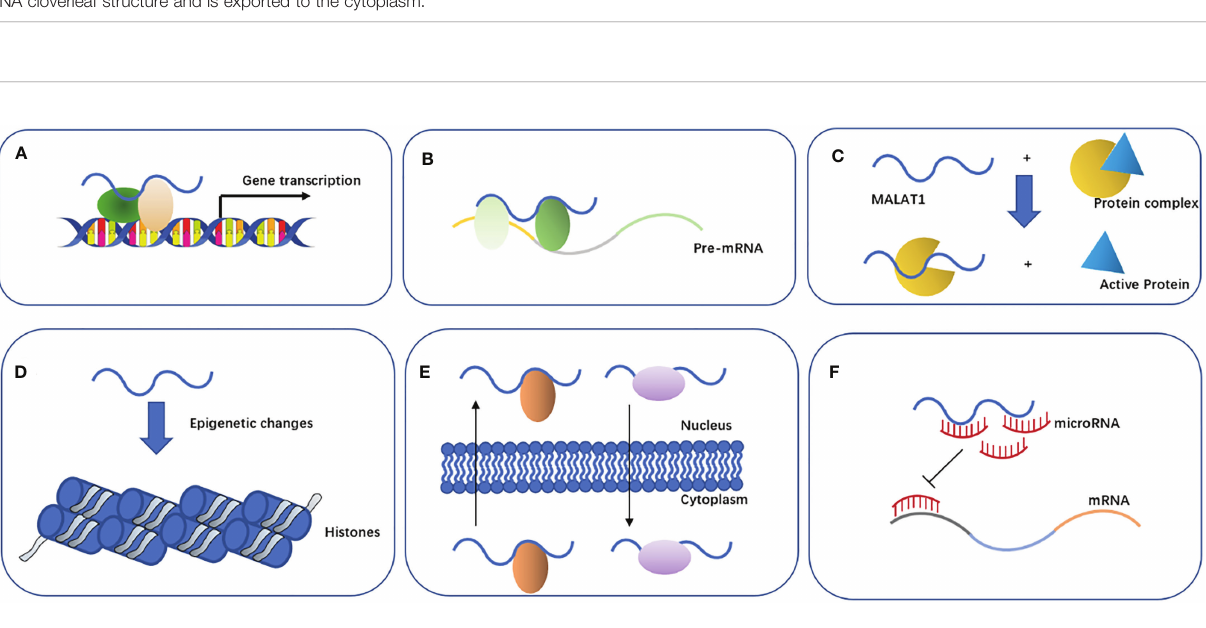
FIGURE 2 | Properties and biological functions of MALAT1. (A) Affects gene transcription. (B) Affects the alternative splicing of pre-mRNAs. (C) Regulates protein activity. (D) Mediates epigenetic changes. (E) Promotes nuclear and cytoplasmic translocation of cellular proteins. (F) Acts as an endogenous miRNA